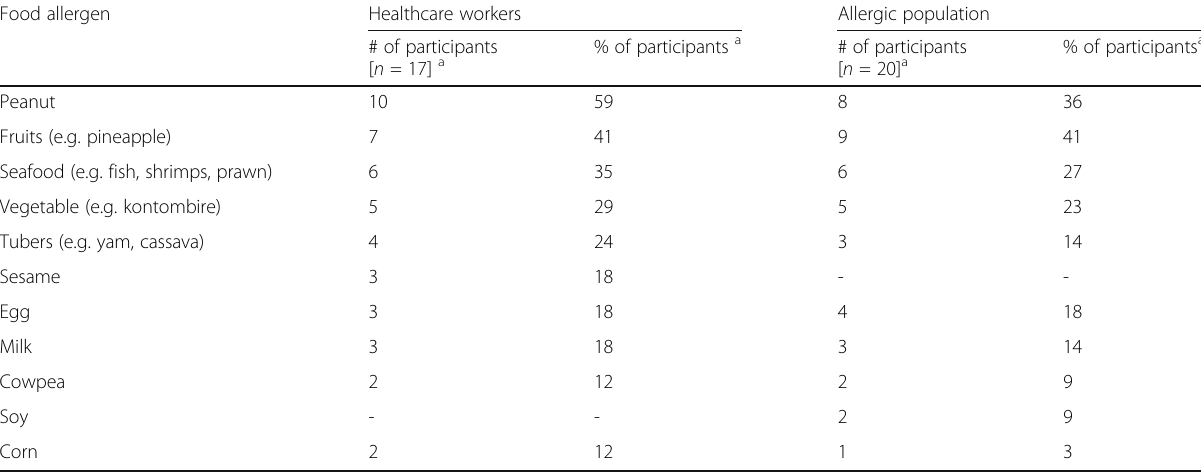
Table 3 Most frequently reported or presented food allergens at healthcare institutions Food